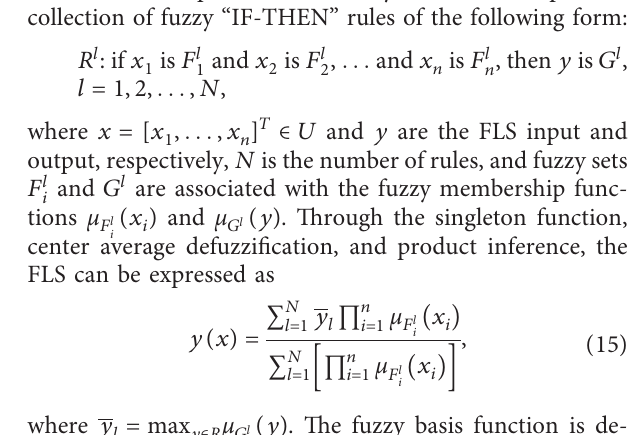
2.2. Fuzzy Logic Systems (FLSs). The FLS is composed of three main components: fuzzy rule base, fuzzification,